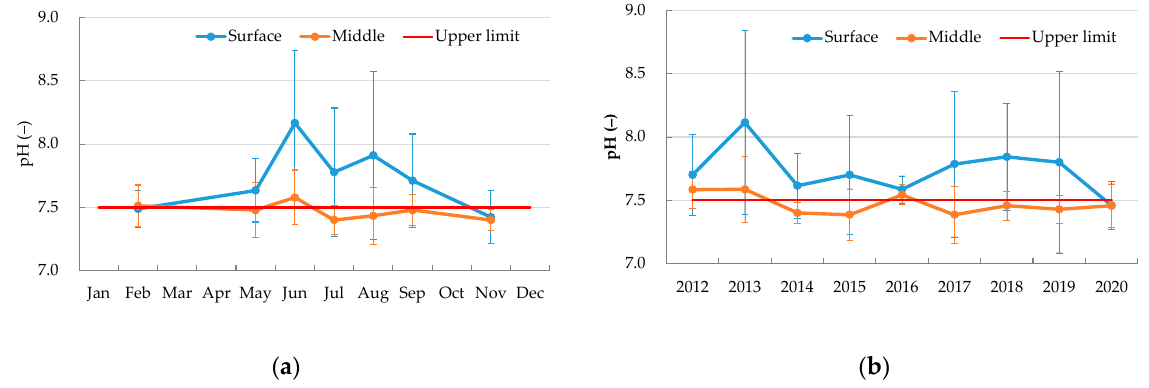
Figure 2. Average pH of Sankyo RRR: ( a ) seasonal trend (2012–2020); ( b ) secular trend; error bar: SD.